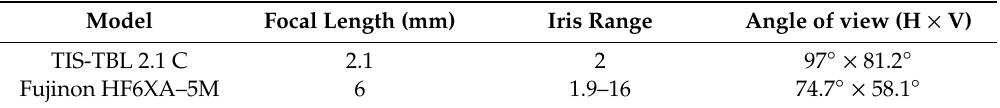
Table 2. Main technical data of lenses used in the prototype (from the Imaging Source Europe GmbH company and FUJIFILM Corporation).